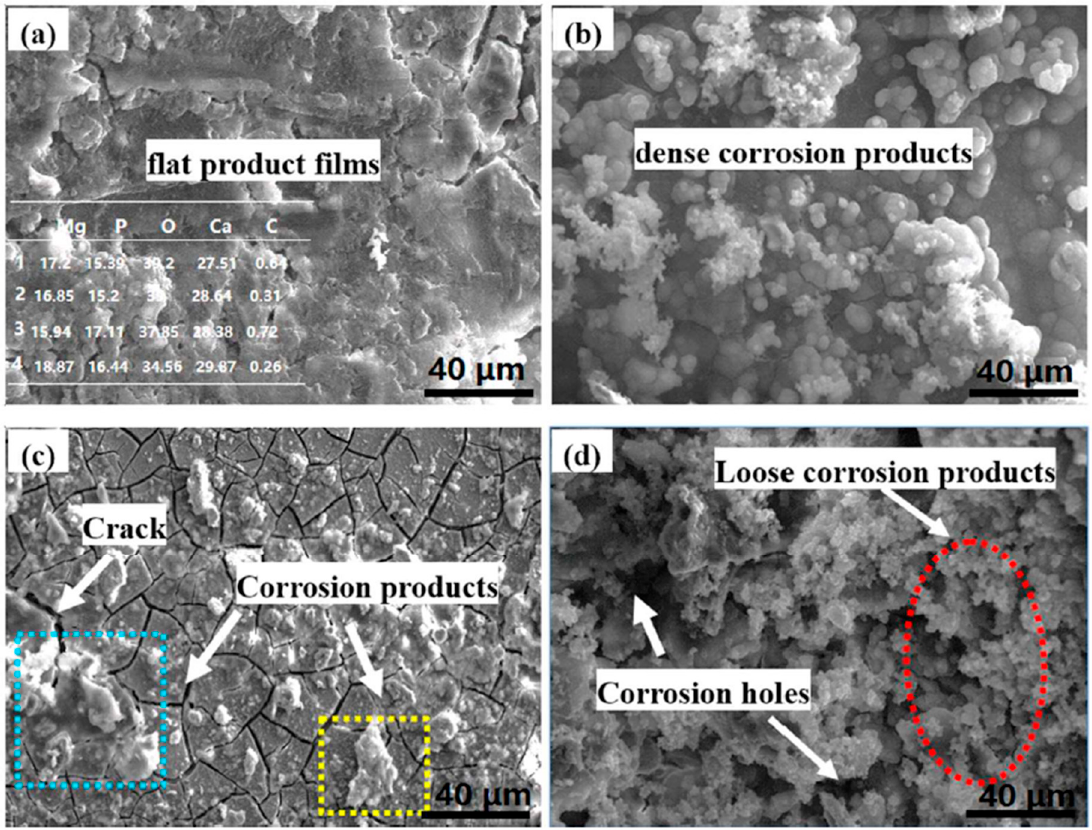
Figure 6. SEM micrographs of corrode surface after immersion test: ( a ) MZM; ( b ) MZM-0.38% Ca; ( c )